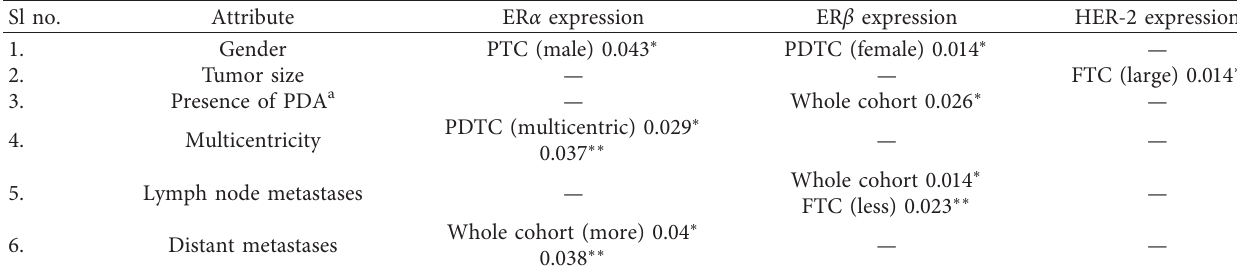
Table 4: Summary of the significance of ER α , ER β, and HER-2